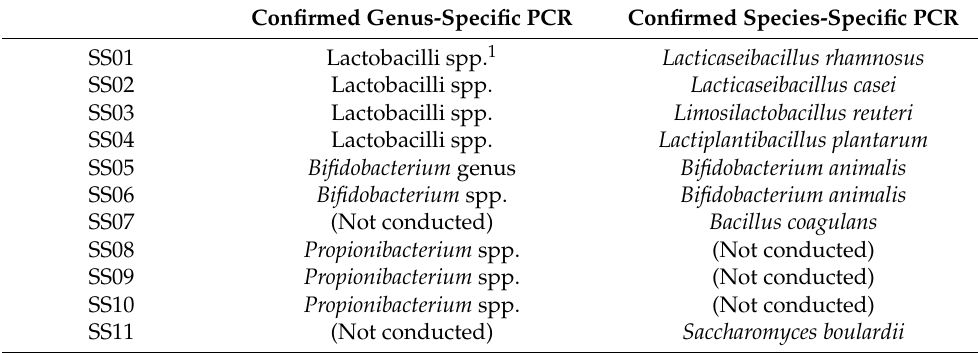
Table 7. Presence of conducted genera-specific and species-specific PCR products of single strain